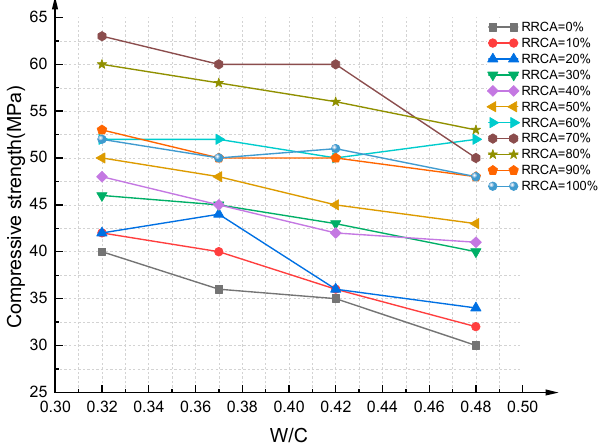
Figure 13. Compressive strength experiment results of RAC cube specimens (P2).